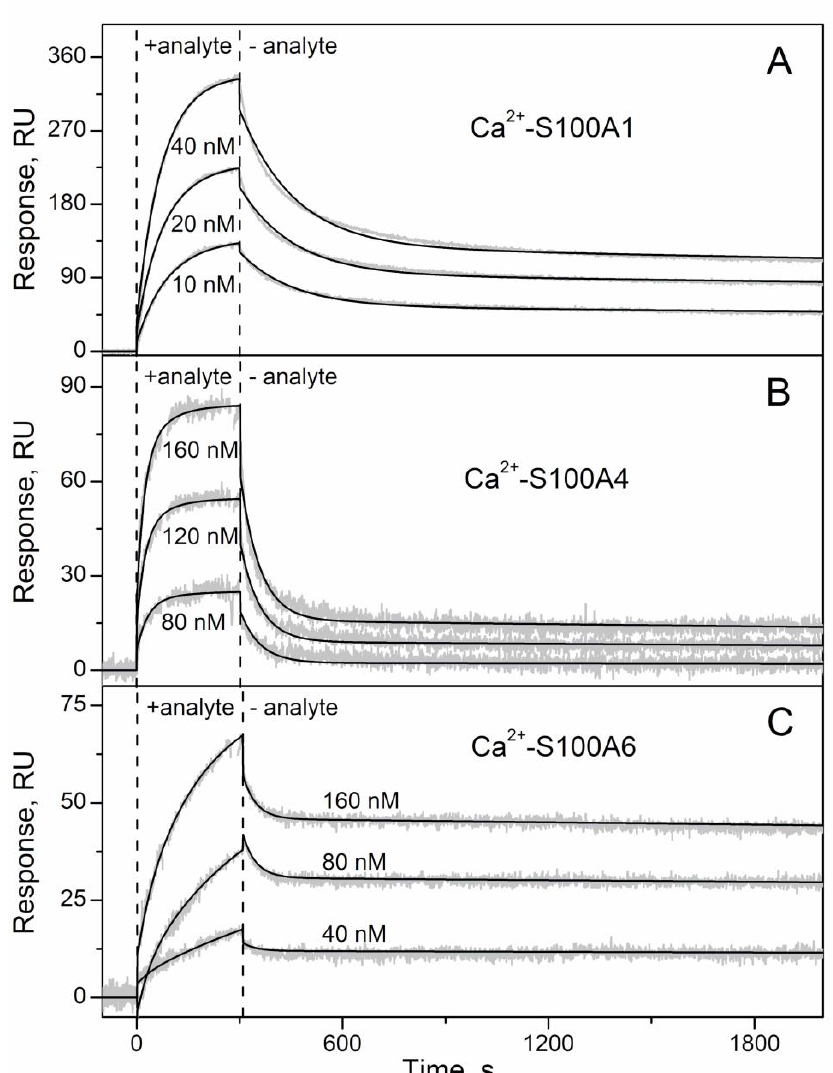
Figure 2. Kinetics of the interaction between IFN- β - and Ca 2+ -bound S100 proteins at 25 °C (1 mM CaCl 2 , pH 7.4), monitored by SPR spectroscopy using IFN- β as a ligand and S100A1 (panel A ), S100A4 ( B ) or S100A6 ( C ) as an analyte (0.25 – 5 µM). The sensograms for control experiments are also indicated: Ca 2+ -depleted S100 proteins (1 µM; 1 mM EDTA) were used as an analyte; IFN- α served as a ligand. Grey curves are experimental, while black curves are theoretical, calculated according to the heterogeneous ligand model [1] (refer to Table 1 for the fitting parameters).